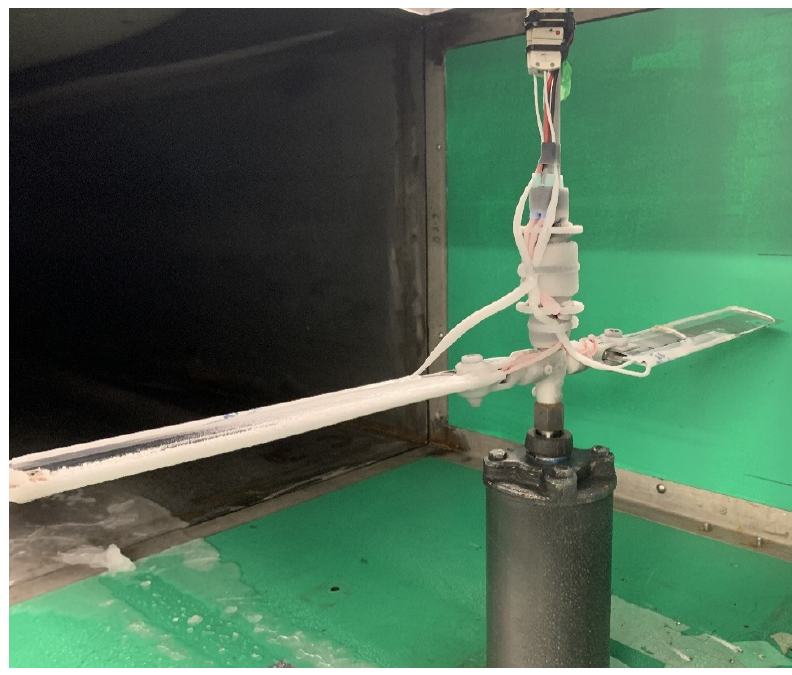
Figure 4. Rotor Prototype in Wind Tunnel after a De-Icing Test.